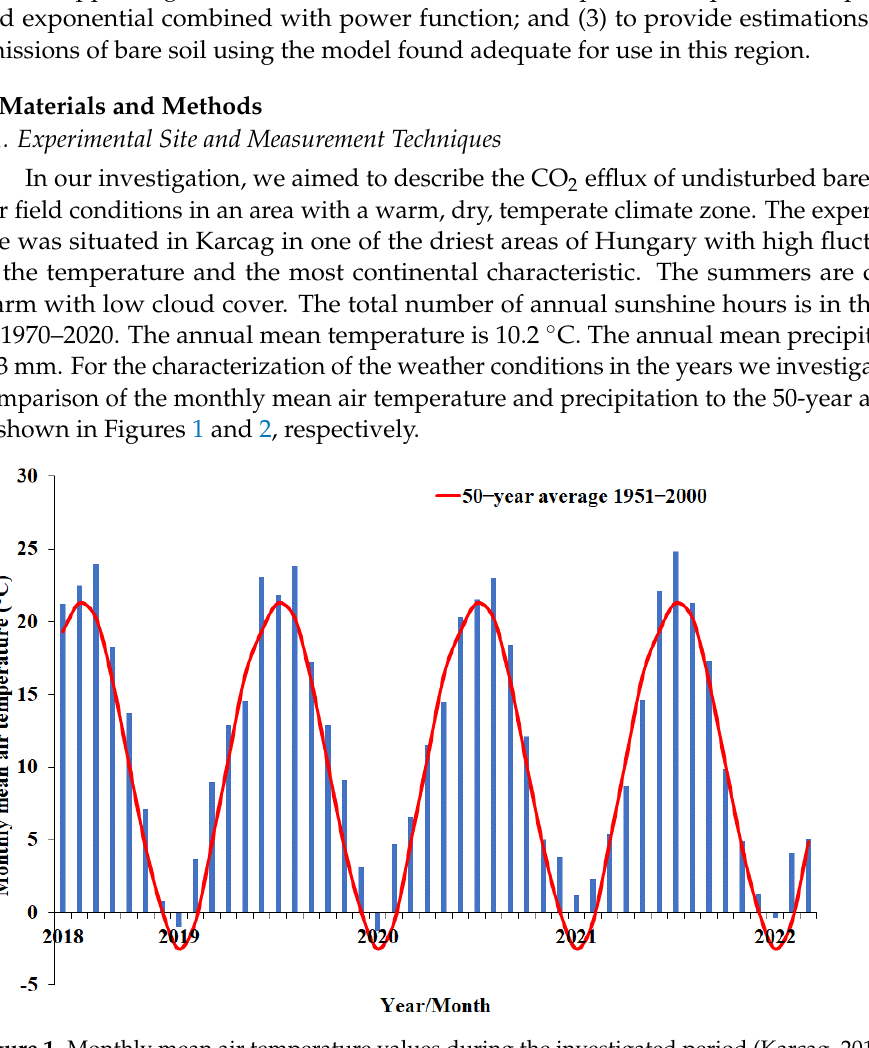
Figure 1. Monthly mean air temperature values during the investigated period (Karcag, 2018 – 2022).